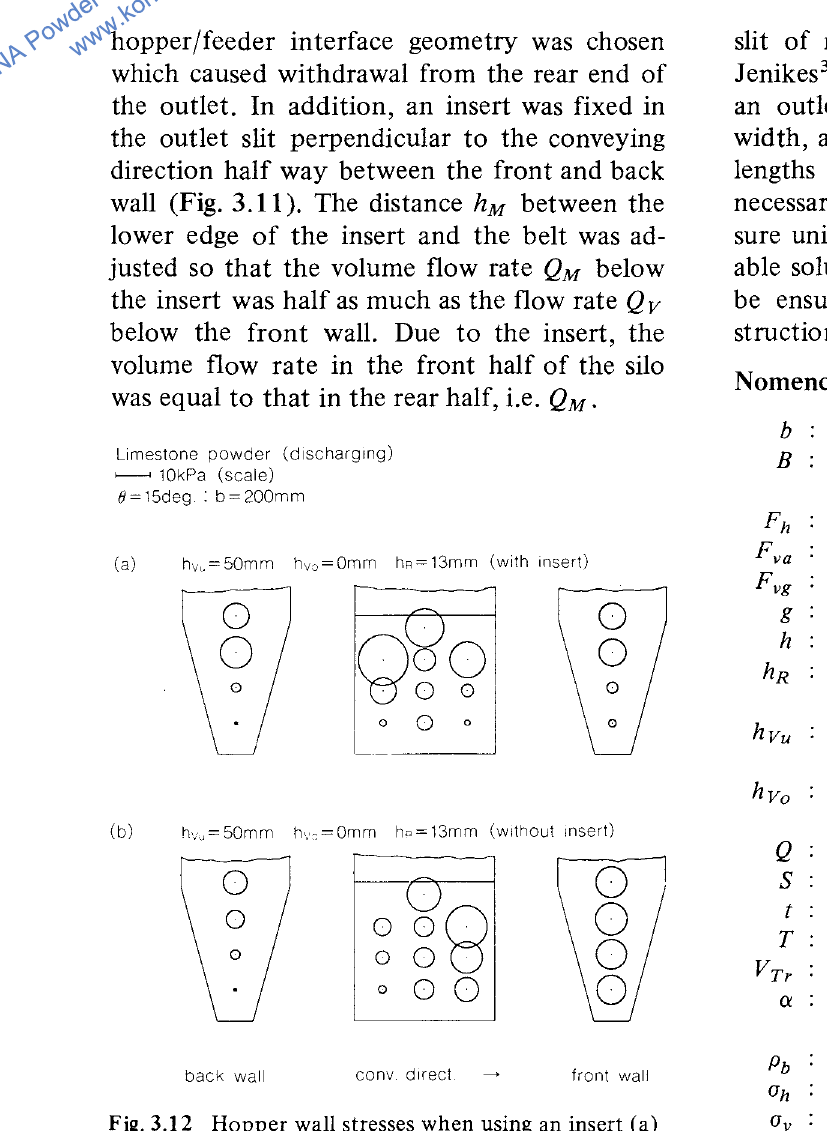
Fig. 3.12 Hopper wall stresses when using an insert (a) and without an insert (b) (limestone powder) Measurements carried out with a well ad justed insert show an even stress distribution and no occurrence of dead zones, even after discharge over long periods of time (Fig. 3.12.a).